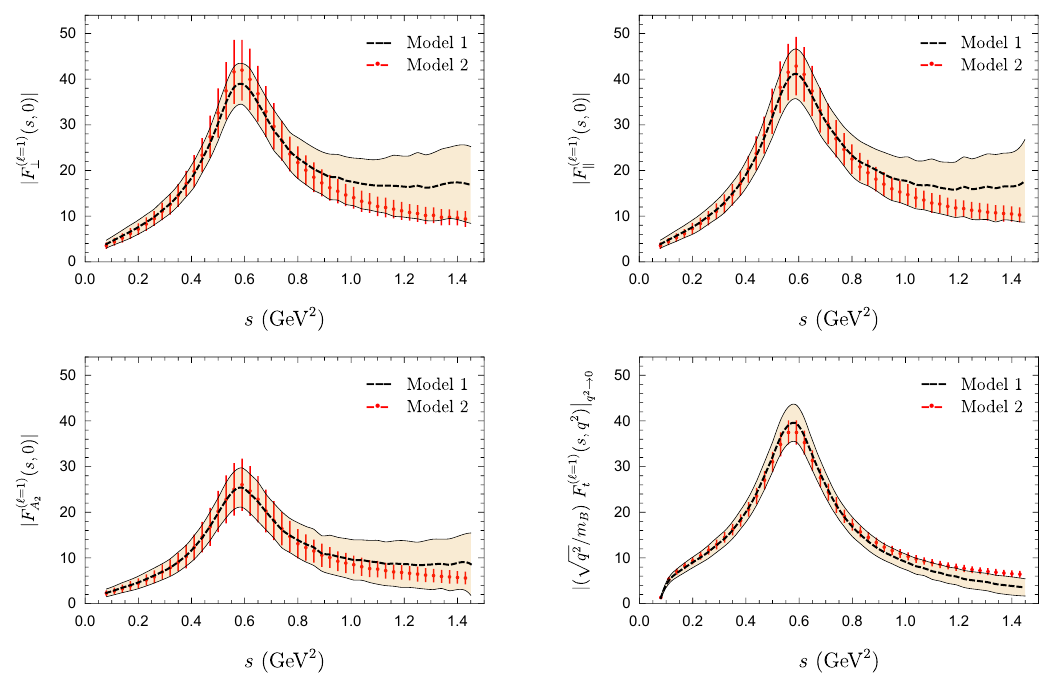
Figure 2 . B ! (cid:25)(cid:25) form factors at q 2 = 0 as a function of the dipion mass, within the models of table 2 (Model 1) and table 3 (Model 2). Shaded regions and error bars account for all uncertainties.